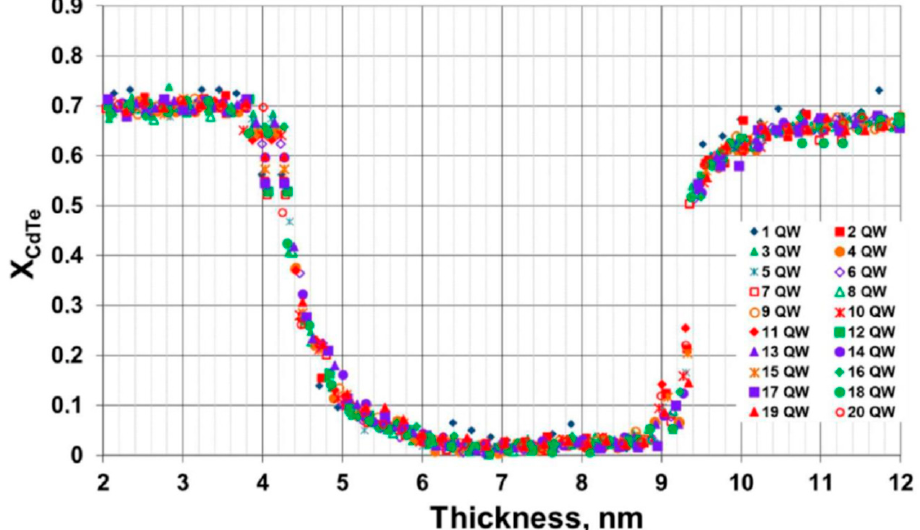
Figure 2. The composition distribution throughout the thickness for the initial 20 periods of the HgTe/Hg 0.3 Cd 0.7 Te MQW. The color symbols represent the well number.